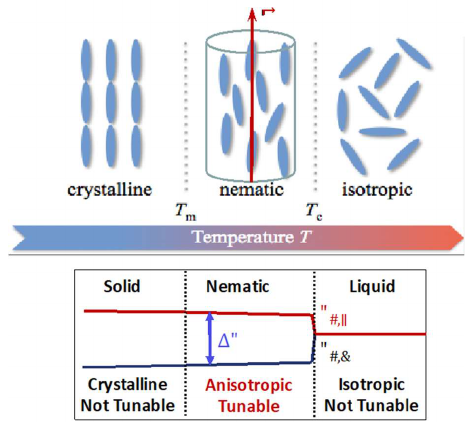
Figure 5. Schematic of a nematic liquid crystal material depending on the temperature, exhibiting a perfect alignment with the order parameter S = 1 in crystalline solid state ( left ), indicating time- and space average directions of the molecules (for a Liquid Crystal (LC) unit volume element characterized by the director → n ) with order parameter 0 < S < 1 in the nematic phase ( middle ) and no molecular ordering with the order parameter S = 0 in liquid state ( right ).